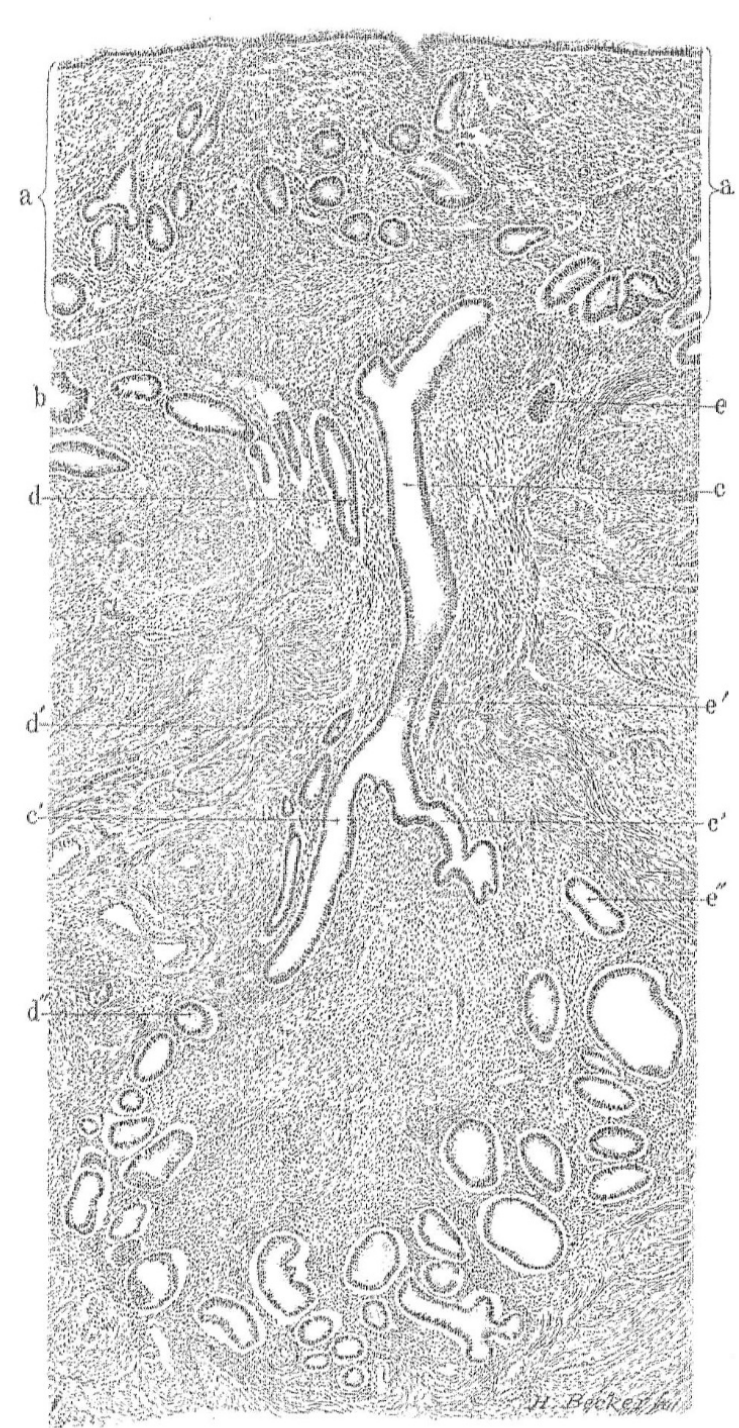
Figure 1. Histological section of the uterus with adenomyosis. The gland (c) within the muscle (b) is in continuity with the mucosa (a). The section also demonstrates gland continuity and convolutions deep within the muscle layer. In this illustration (c,c’) represent one gland and its branches and (d,d’,d”) and (e,e’,e”) represent adjacent glands. The illustration demonstrates the meticulous work by Thomas Cullen (1908).